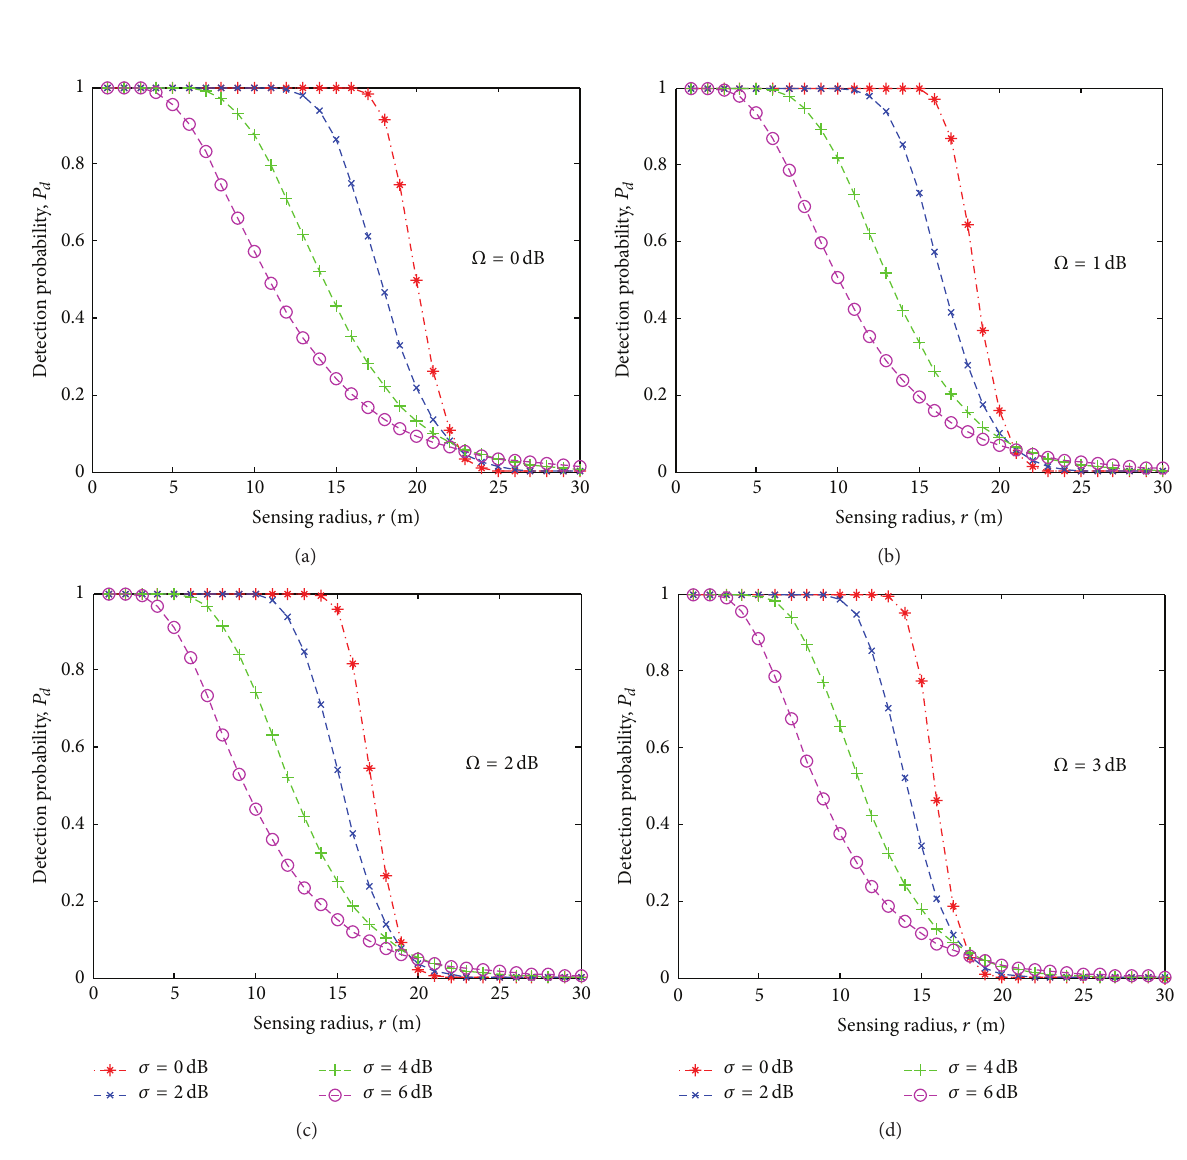
Figure 4: Detection probabilities 𝑃 𝑑 versus the sensing radius 𝑟 for different shadowing and multipath